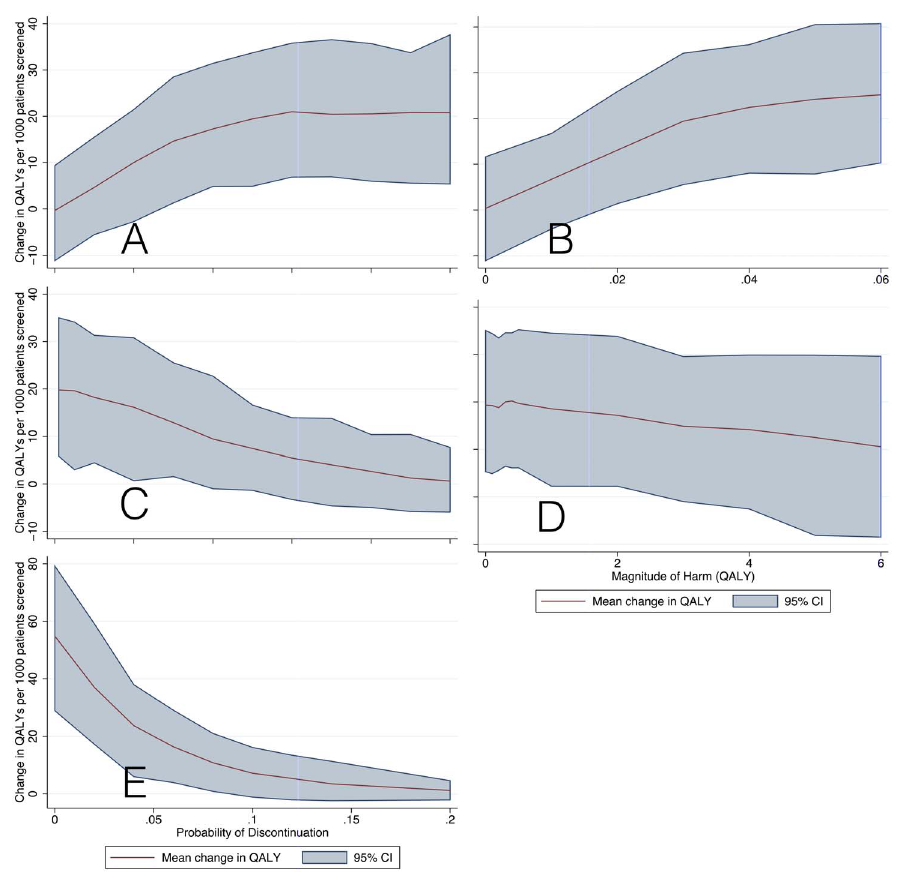
Figure 4. One-way sensitivity analyses. The y-axis for each panel displays the change in the number of expected QALYs with the implementation of a treatment intervention vs. no intervention in a 55 year-old population as treatment efficacy, harm and probability of discontinuation are varied across the x-axis. A) RRR ceiling B) RRR slope C) Probability of Harm D) Magnitude of Harm E) Probability of